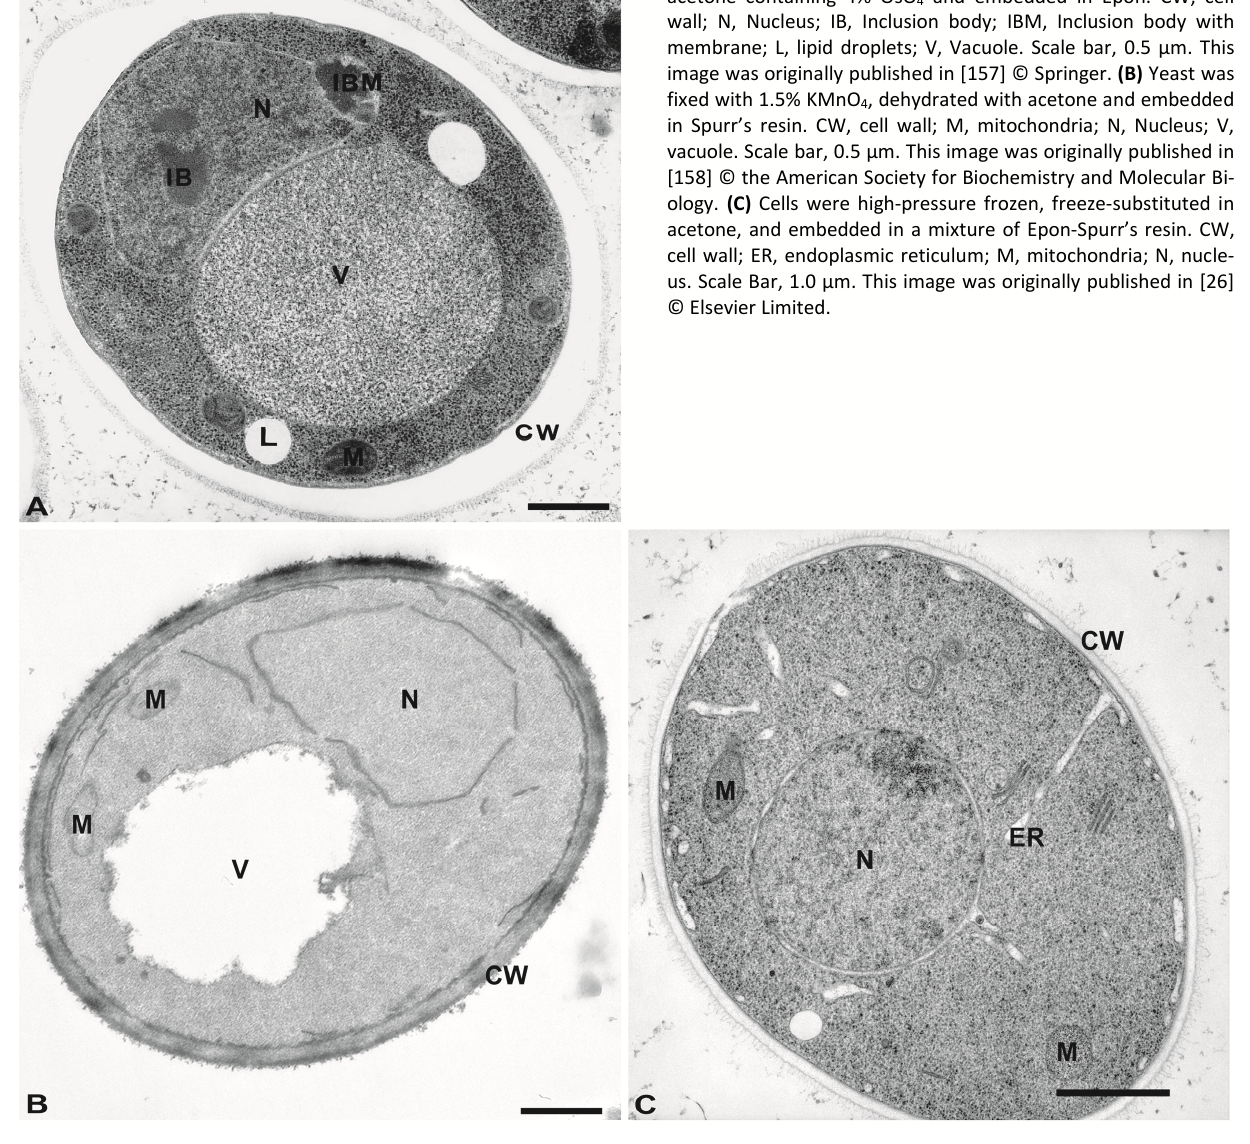
FIGURE 2: Morphology of yeast cells embedded in epoxy